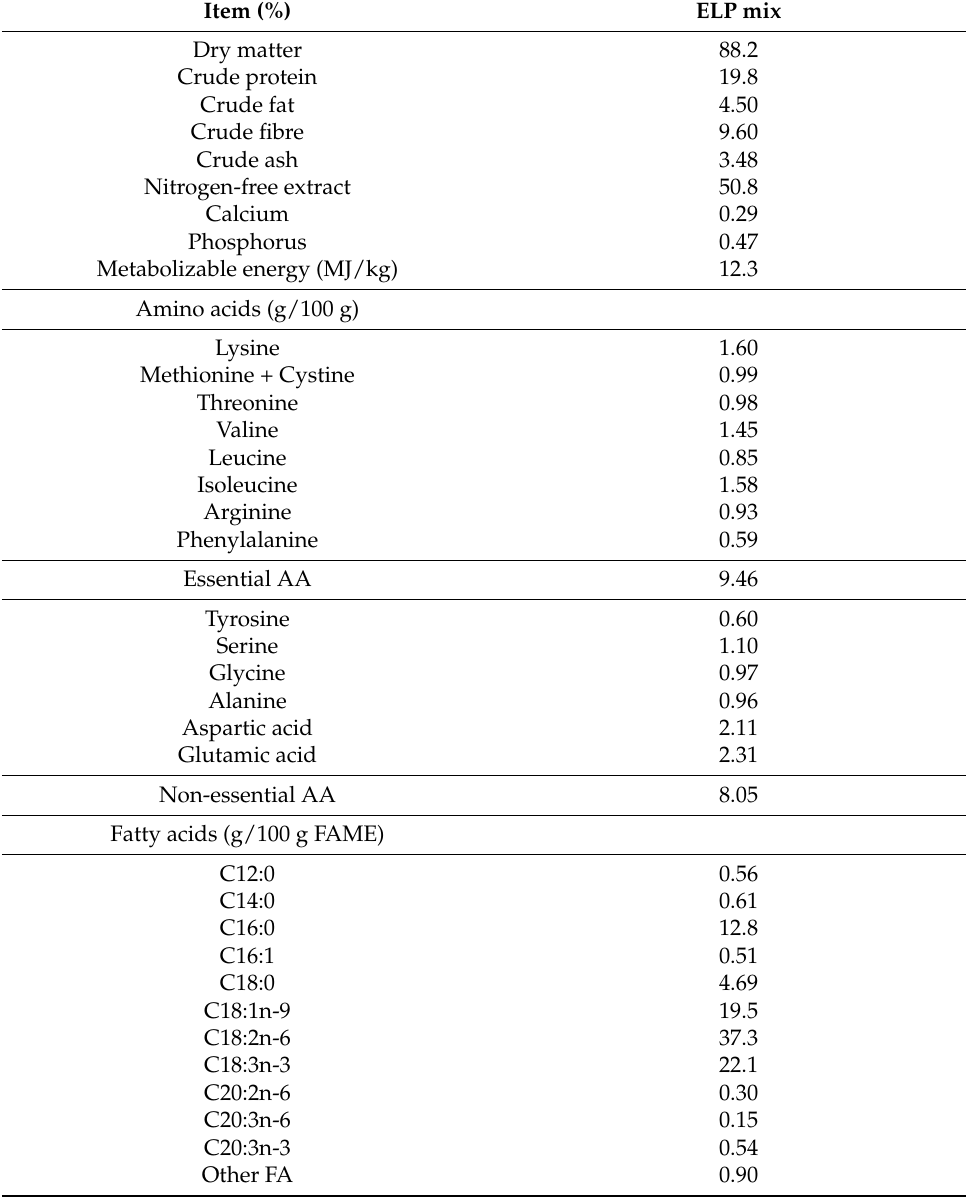
Table 2. Analyzed composition of dietary-extruded linseed:pea